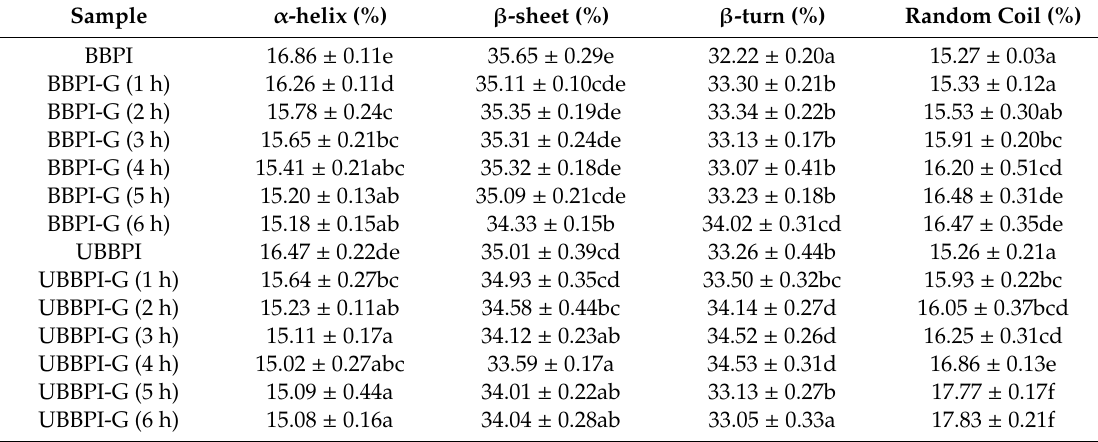
Table 2. Secondary structure distribution of BBPI by wet heating and ultrasound treatment Maillard reaction for 1–6